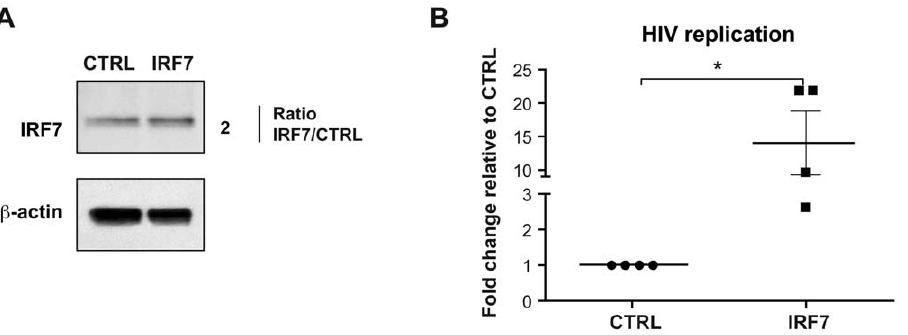
Figure 5. IRF7 overexpression increases HIV-1 replication in primary macrophages. A) Western blot for IRF7 protein, 24 hours post- transfection of macrophages overexpressing IRF7 showed a 2 fold increase compared to empty vector control. The densitometry of the bands was normalized to that of b -actin. The ratio is shown next to the respective panels. Results shown are representative of 2 independent experiments. B) TAT spliced expression was augmented 14 fold in primary human macrophages overexpressing IRF7 compared to empty vector control. The qRT-PCR results were normalized to the level of 18 S. An * denotes a significant difference (P , 0.05, one sample t -test) compared to the empty vector control. Each symbol in a group represents one independent